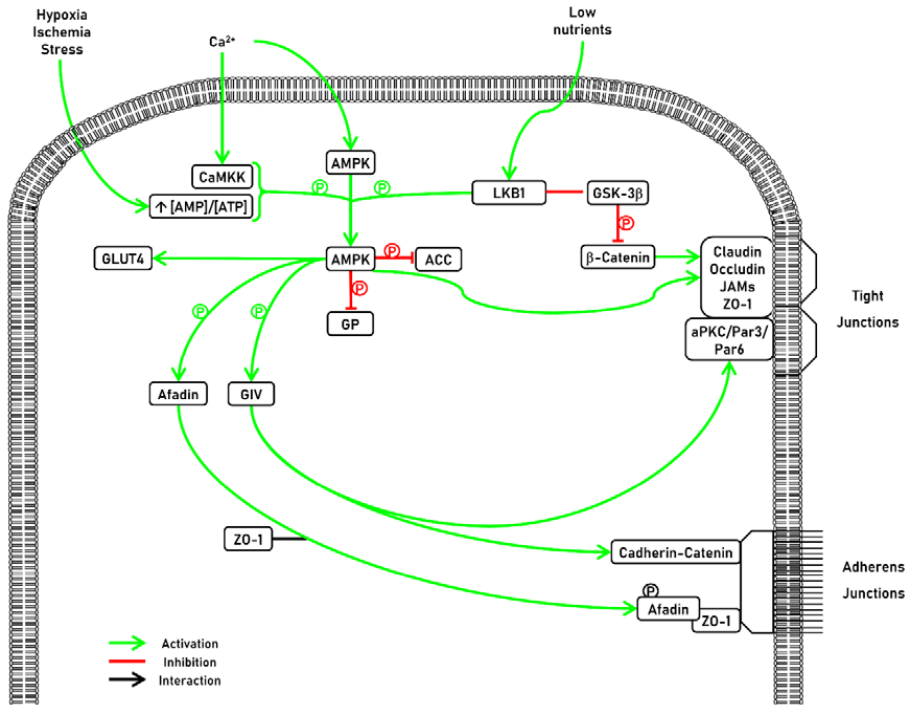
Figure 3. Representative schema of AMPK activators and substrates.